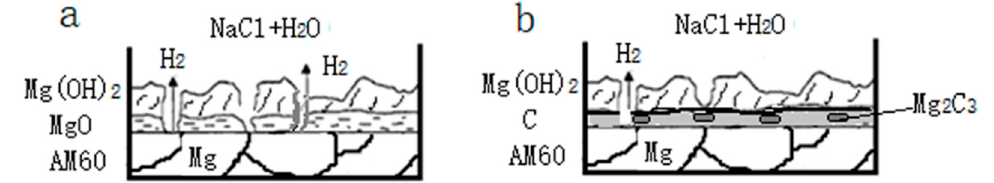
Figure 9. A schematic presentation of the corrosion of different samples: ( a ) corrosion of AM60 Mg alloy, and ( b ) corrosion of AM60 with C nanolayer.